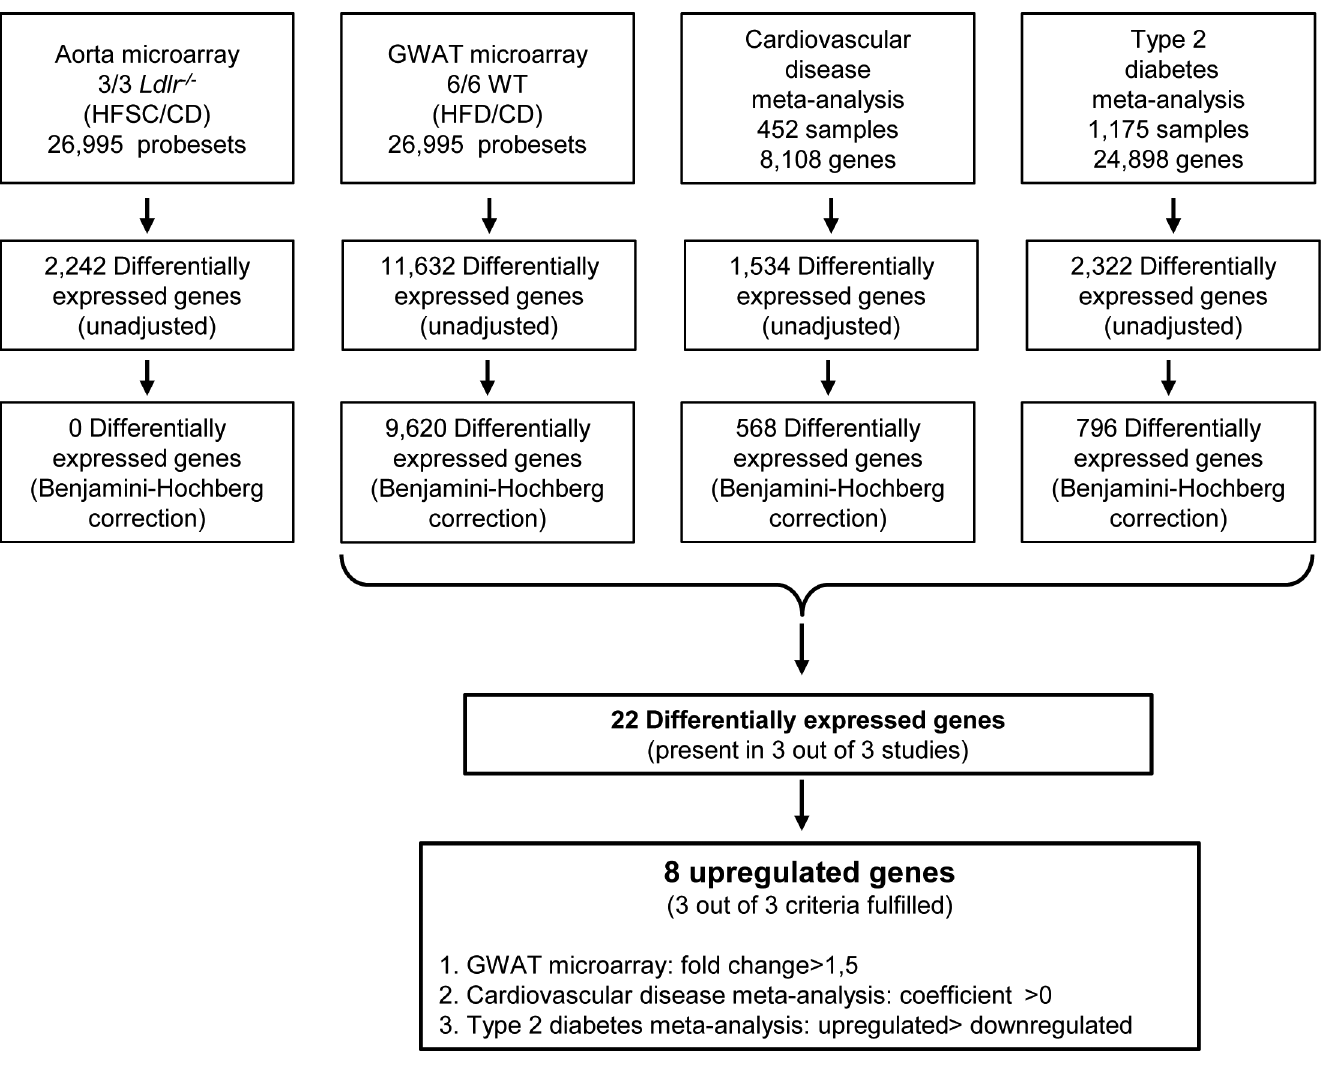
Figure 1. Screening and selection of a short list of potential new targets. Diagram bounding several stages to identify common genes in car- diovascular disease and obesity models. Differentially expressed genes from cardiovascular disease meta-analysis and type 2 diabetes and adipose tissue microarrays were combined to identify common genes upregulated in all 3 studies. First, common genes from all 3 databases were identified (22 genes) to proceed with identification of the upregulated genes in 3 out of 3 studies (8 genes). The aorta microarray was not included in the selection procedure, as no differentially expressed genes were found after Benjamini-Hochberg